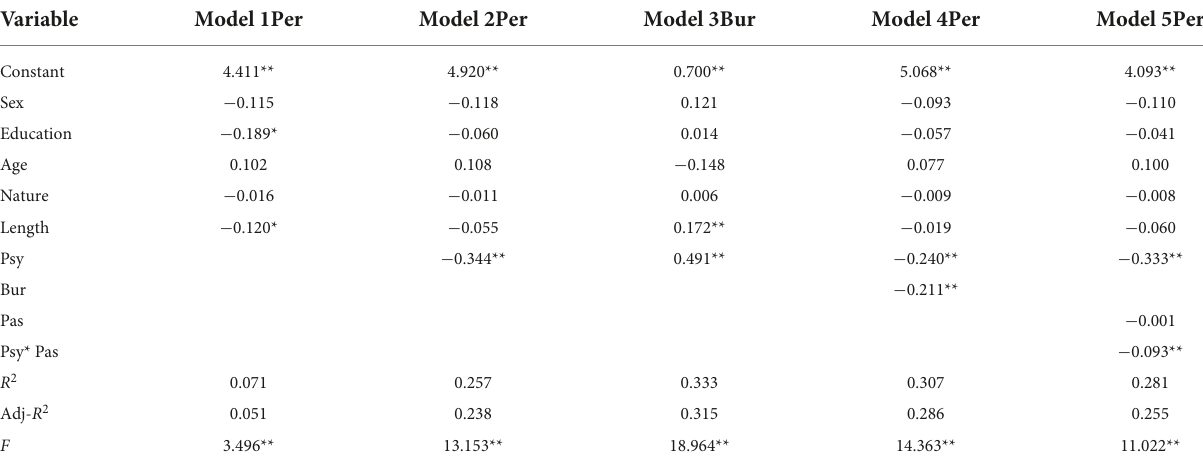
TABLE 4 Results of relationship between psychological contract breach and job performance of new generation of employees ( N = 235).